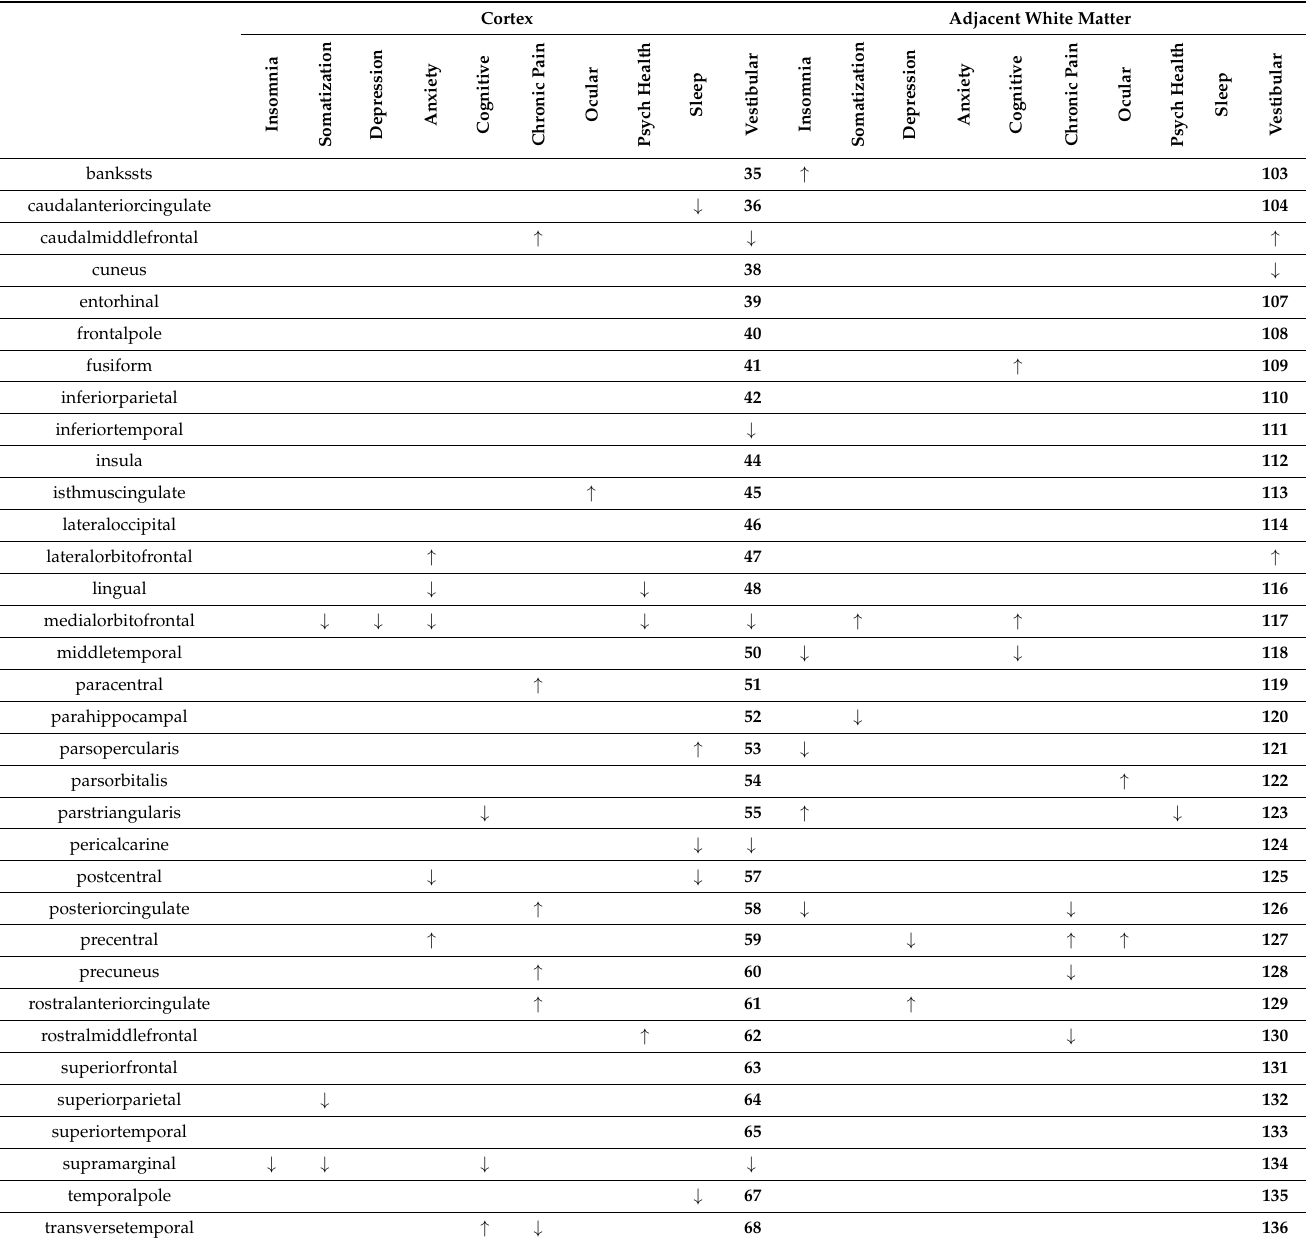
Table 4. The right-side regions whose neuroelectric activity values contributed to the symptom- specific classifiers reported in Table 2 are shown. Activity in regions marked “ ↑ ” was higher in those who screened positive; those marked “ ↓ “ were